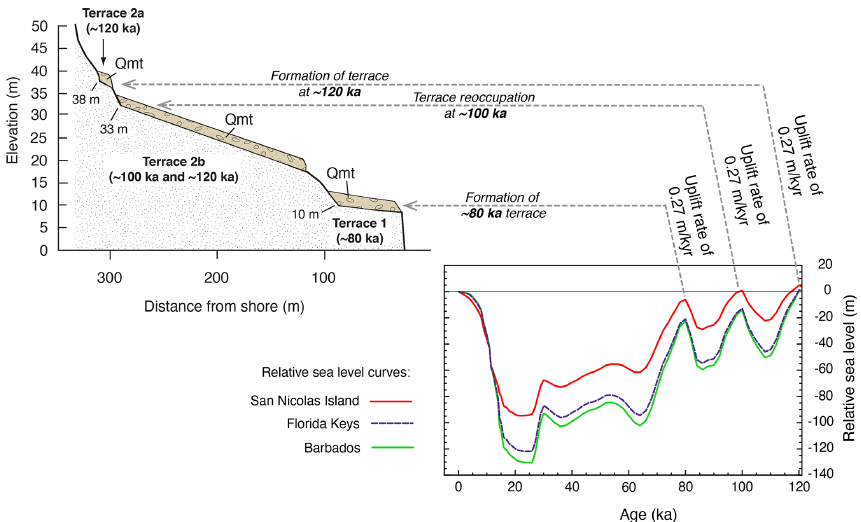
Figure 45. Cross section of the lowest marine terraces on San Nicolas Island, California, and modeled sea-level curves for this island, the Florida Keys, and Barbados (from Muhs et al., 2012), showing the link between sea-level history, uplift rate, and terrace geomorphology, influenced by glacial isostatic adjustment (GIA) processes. Qmt: Quaternary marine terrace